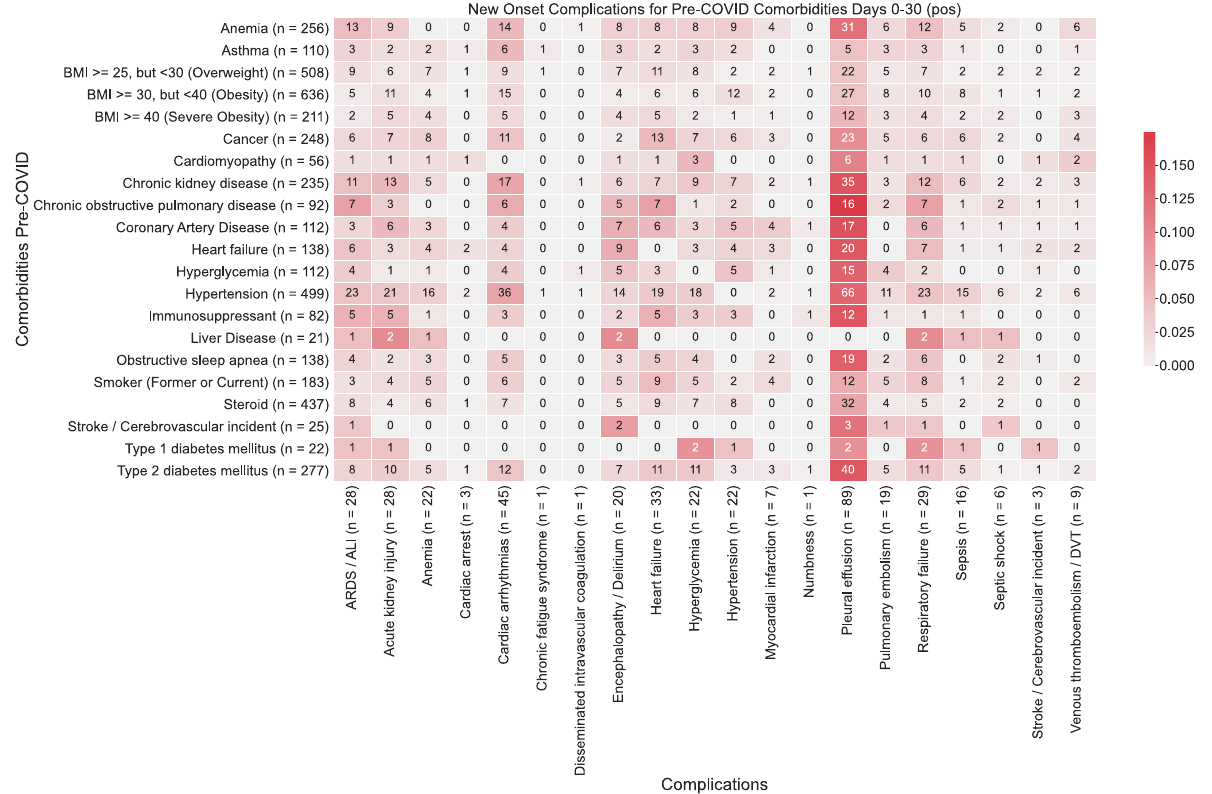
Fig. 2 Heatmap showing associations between comorbidities and early-onset complications (0 – 30 days post-PCR) in COVID-19 patients. The color of each (comorbidity, complication) pair corresponds to (number of patients with the comorbidity that had the complication for the fi rst time in the time window (0 – 30 days))/(total number of patients with the comorbidity). Darker shades of red correspond to higher rates of complications, and lighter shades of red correspond to lower rates of complications. A patient is determined to have comorbidity if it is recorded in their clinical notes with positive sentiment any time before their fi rst positive PCR test. For each comorbidity row and for each complication column, the number of patients is shown in